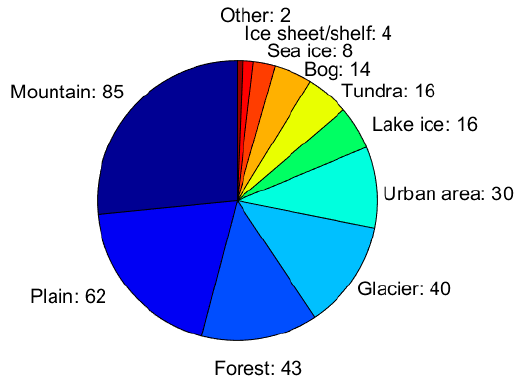
Figure 4. Types of measurement sites reported by the respondents. The width of each slice corresponds to the fraction each site type has, relative to the total number of site types reported (i.e., the sum of the numbers given in the figure).